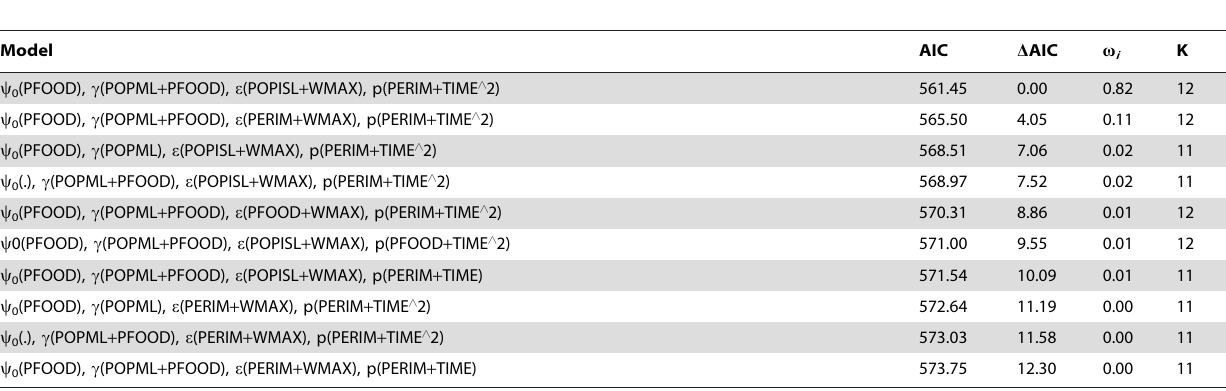
Table 3. The 10 top ranking models depicting initial island occupancy ( y 0 ), colonisation ( c ), extinction ( e ) and detection ( p ).